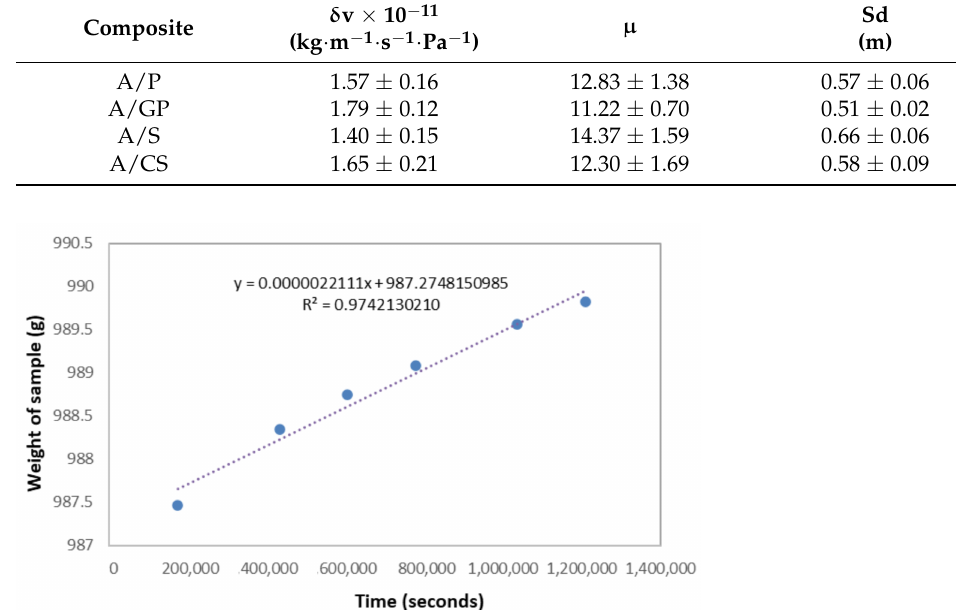
Figure 3. Example of diffusion flow stabilization in a dry cup test of an A/P sample to determine diffusion properties and the linear regression between the mass of the assembly and time with the obtained equation (dotted